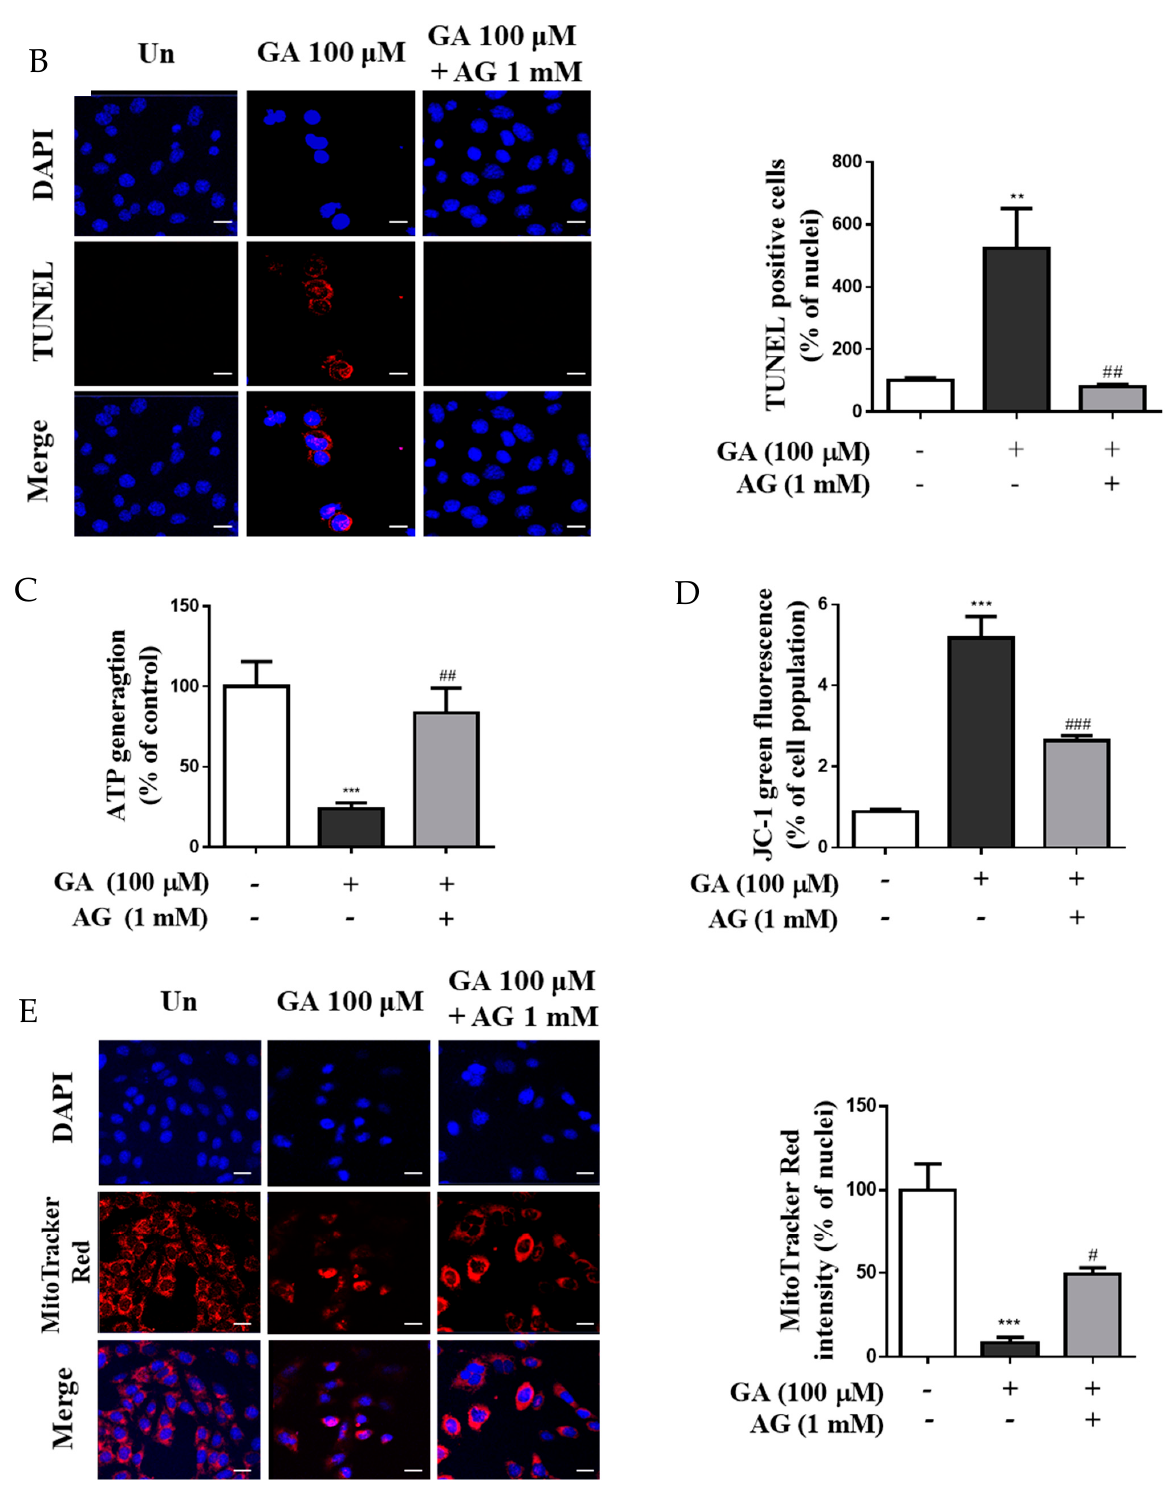
Figure 3. GA induced apoptosis in mesangial cells through mitochondrial dysfunction. Mesangial cells were treated either with GA (100 μ M) or GA (100 μ M) cotreated with AG (1 mM) for 24 h. ( A ) Apoptosis was detected by annexin V-FITC/PI staining and flow cytometry (FACS), and apoptosis was calculated as percentage of apoptotic cells in total cell number. ( B ) Confocal microscopy was used to identify apoptotic TUNEL-labeled cells (red) and DAPI-stained cell nuclei (blue) using a confocal laser scanning microscope. Representative confocal microscopy images were taken